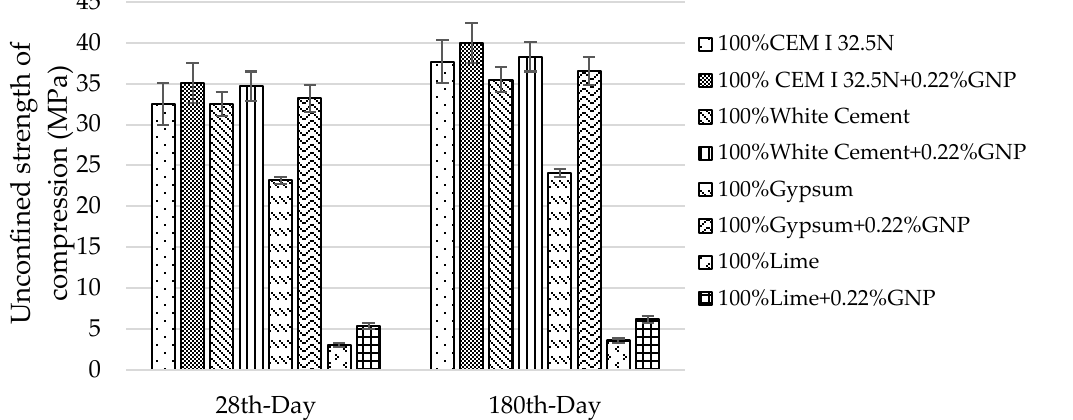
Figure 1. USC results for conventional and technological nanocarbon mortars after curing at 28 d and 180 d.